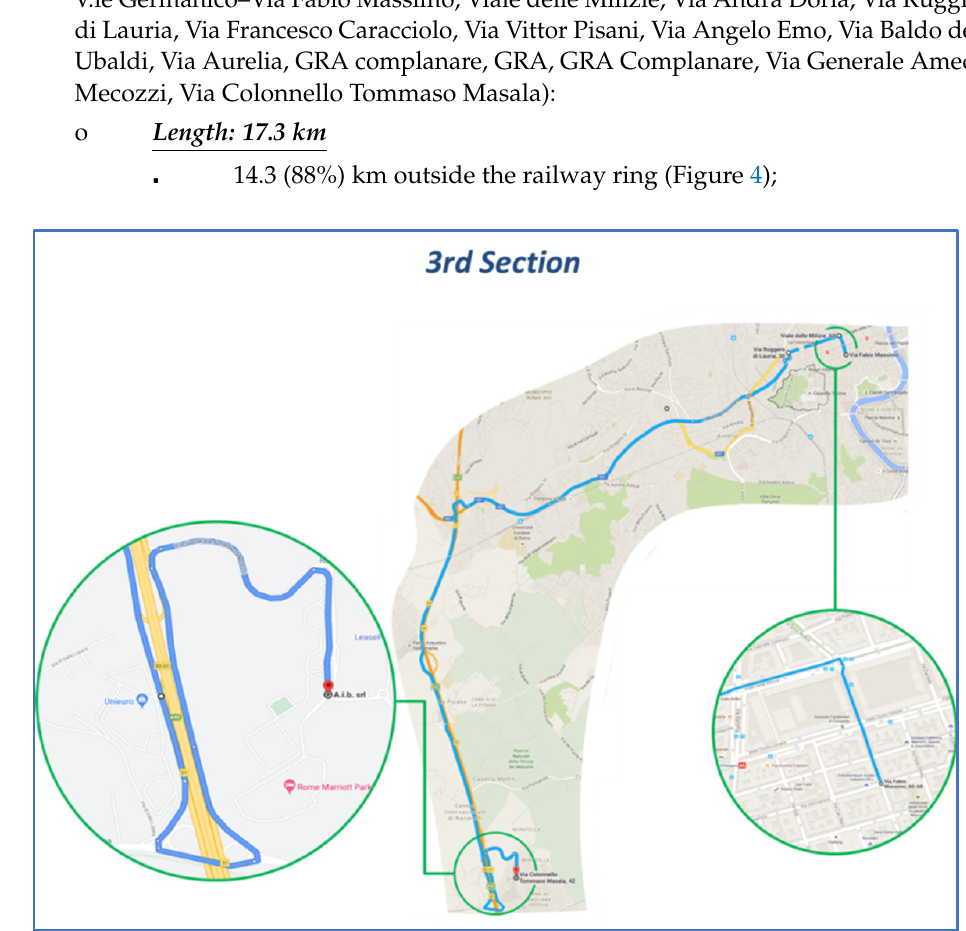
Figure 4. Return: high-speed urban and extra-urban route.